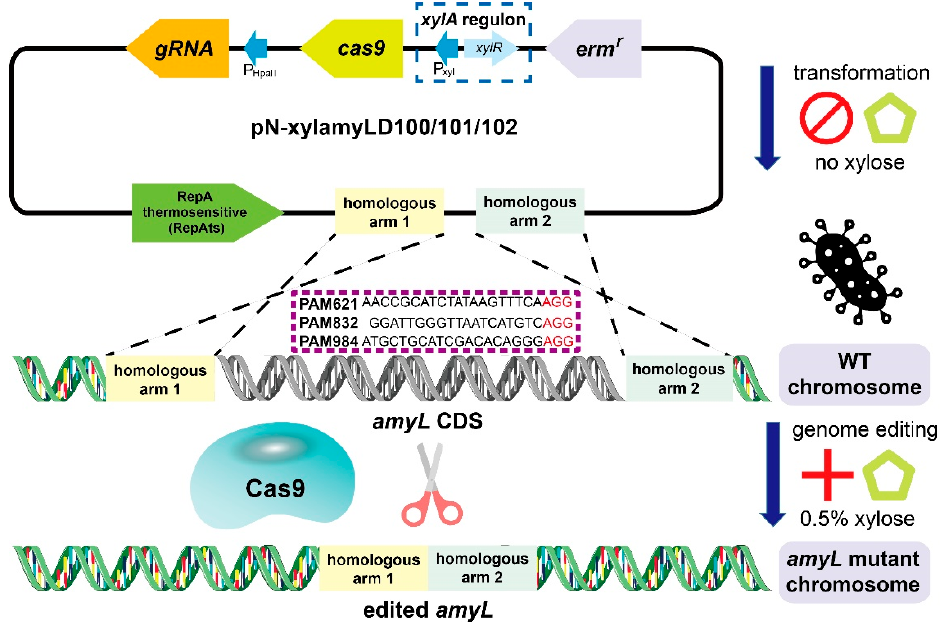
Figure 1. Deletion of gene fragments from the B. licheniformis chromosome using a controllable clustered regularly interspaced short palindromic repeat (CRISPR) / Cas9 system. In the genome-editing plasmid, the expression of the cas9 gene is controlled by a xylA regulon, including the xylose-inducible promoter P xyl and repressor-encoding gene xylR . The sgRNA is inserted downstream of the gram-positive promoter P HpaII . The customized CRISPR / Cas9 vectors target the amyL gene at 3 protospacer-adjacent motif (PAM) loci. Gene fragment deletion was achieved via a homologous recombination event. Two homologous arms connected by black dashed lines show the approximate regions of recombination ( ∼ 300 bp each), and they were incorporated into the CRISPR / Cas9 vector to help cells survive chromosomal double-strand breaks (DSBs). The deleted region within the amyL CDS is shown in grayscale. P HpaII : the constitutive promoter from pMA5. P xyl : the xylose-inducible promoter